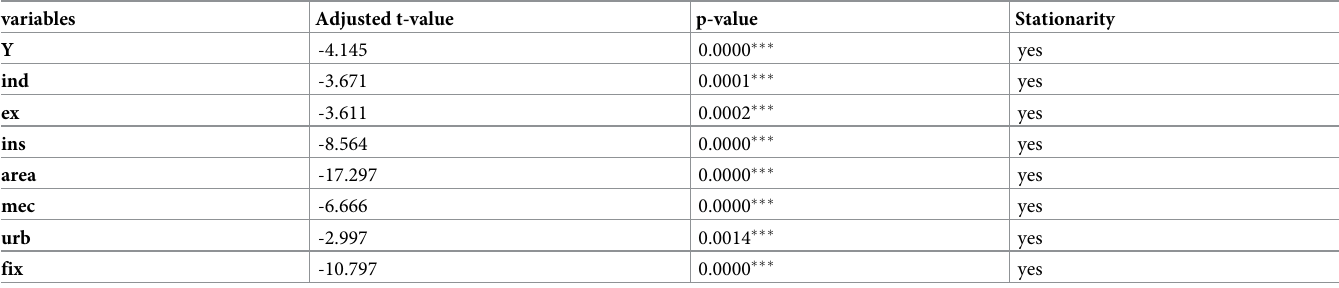
Table 4. Unit root test